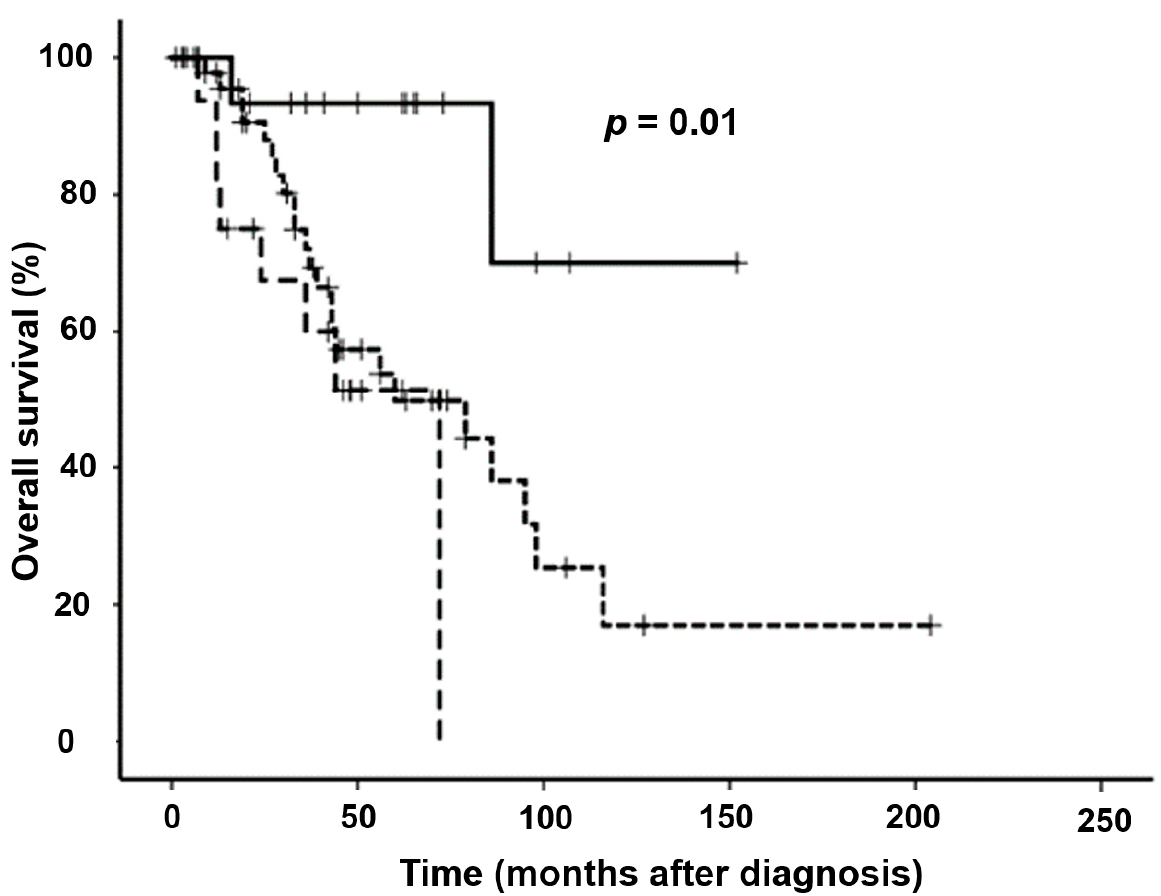
Figure 4. Overall survival of patients with MM with (– –) or without EMD (--) at diagnosis vs. pEMP/SOP ( ── ). Shown Kaplan–Meier are Kaplan–Meier estimates.